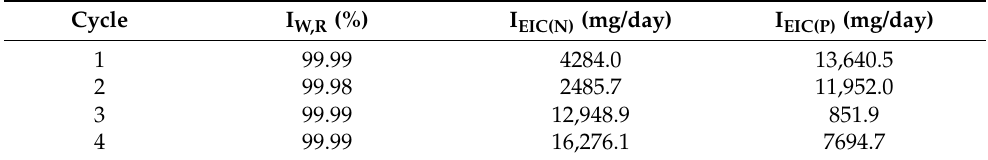
Table 7. Indicator of recovery of water in the treatment process (I W,R ) and effluent inorganic content (I EIC(N) and I EIC(P)